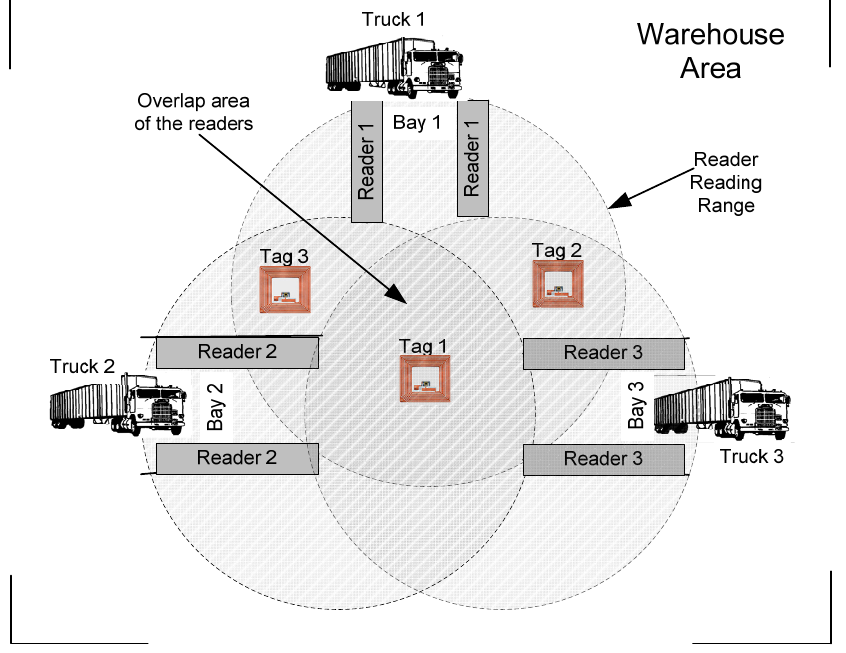
Figure 1. An RFID-enabled system for warehouse loading